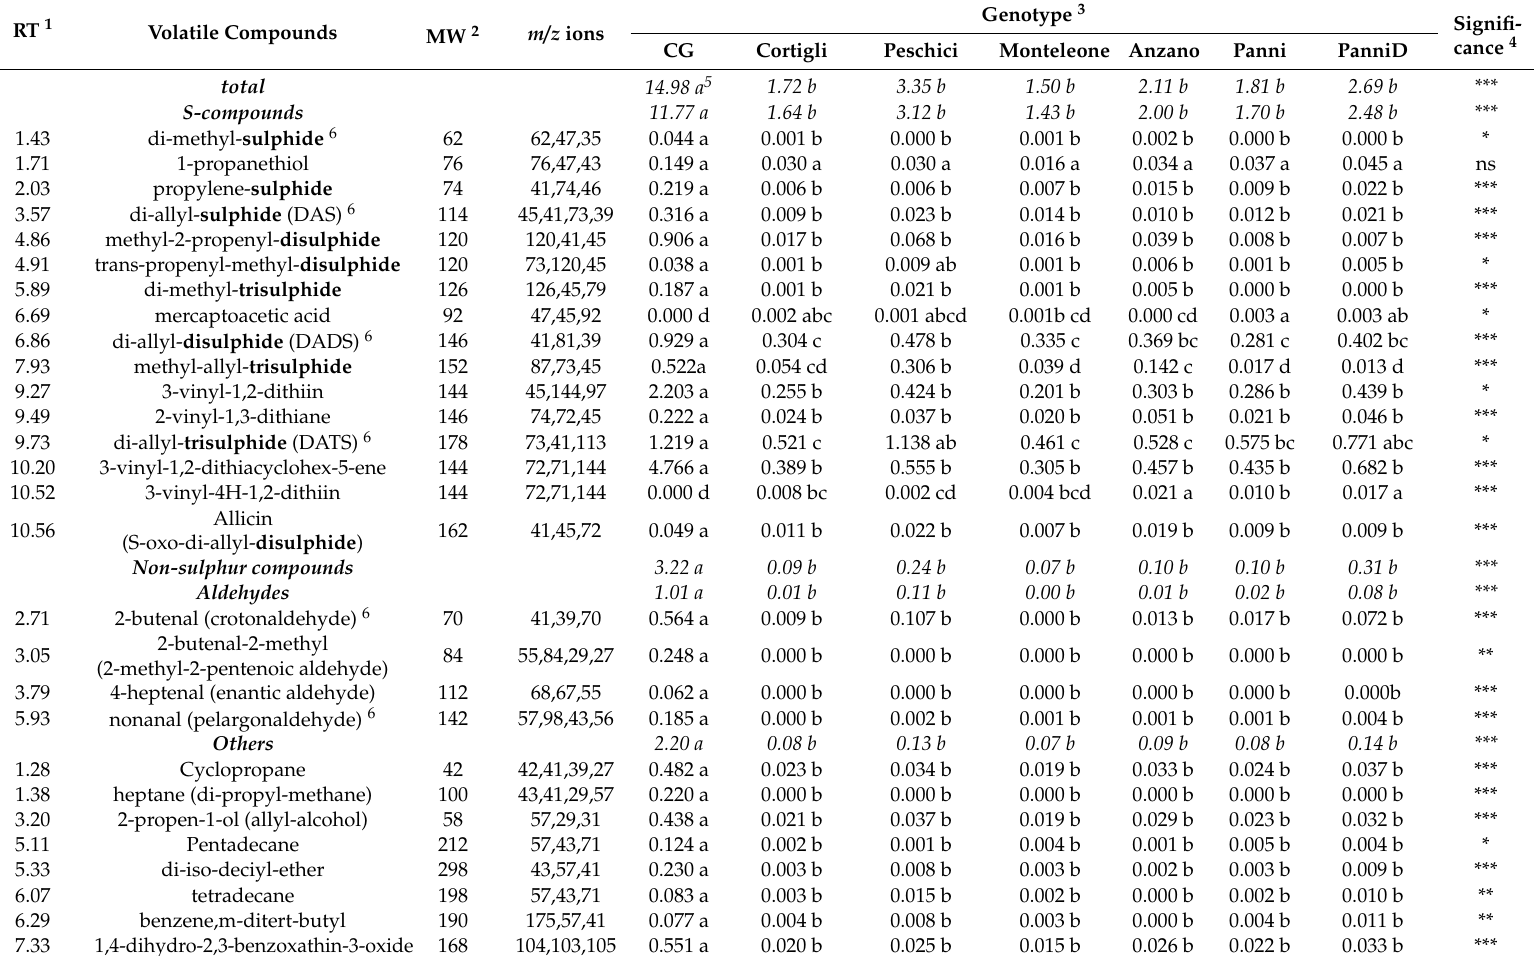
Table 4. Profile of volatile compounds (mg kg − 1 dw) in bulbs of garlic